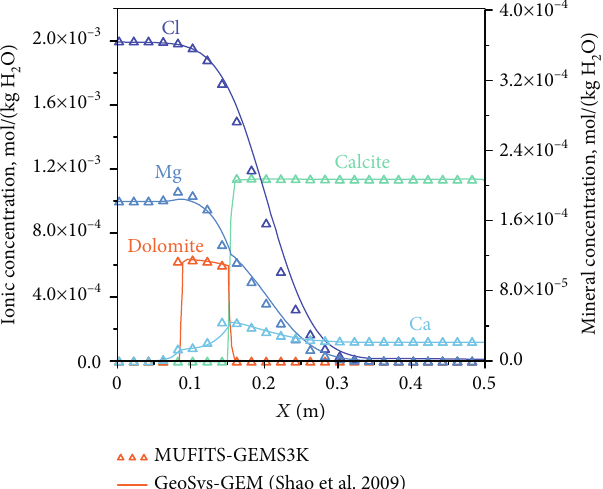
Figure 6: Concentrations of the aqueous components and minerals at t = 21000 s. The solid curves show the results of Shao et al. [24], and the symbols are the results of the MUFITS – GEMS3K coupled